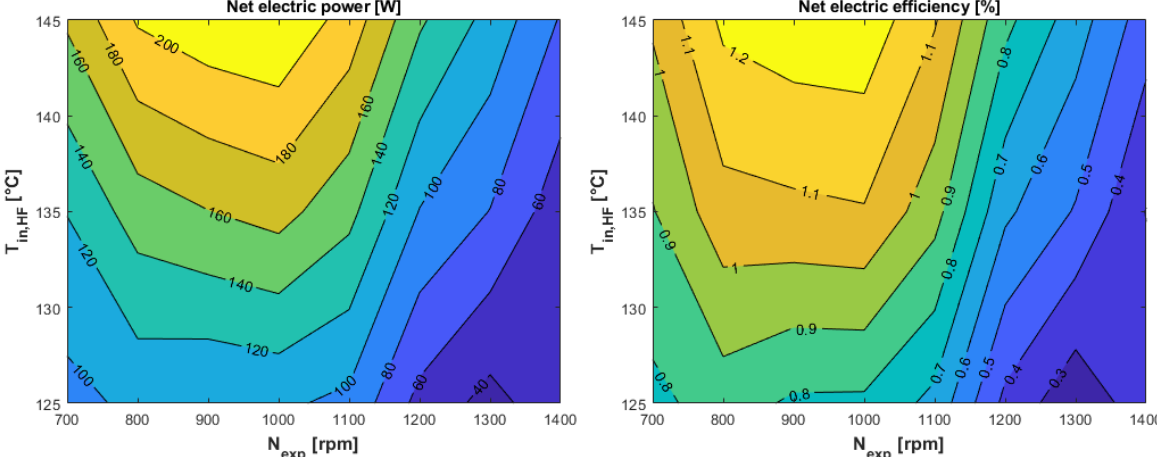
Figure 24. Net electric work ( left ) and net electric efficiency ( right ) maps of the ORC system with the heat source temperature and the expander shaft speed (N p,HF = 1400 rpm, SH = 5 K, SC = 5 K, T in,CF = 15°C, T amb = 15°C).